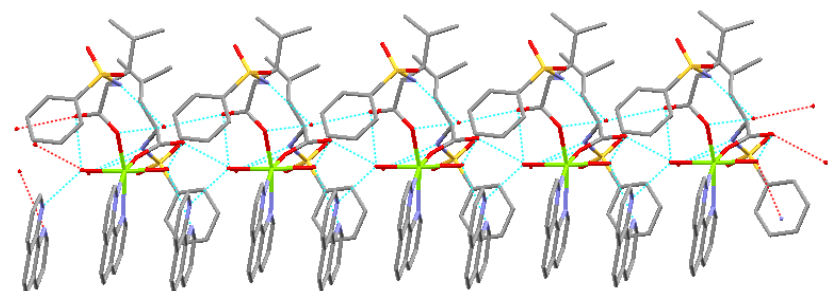
Figure 3. One dimensional chain